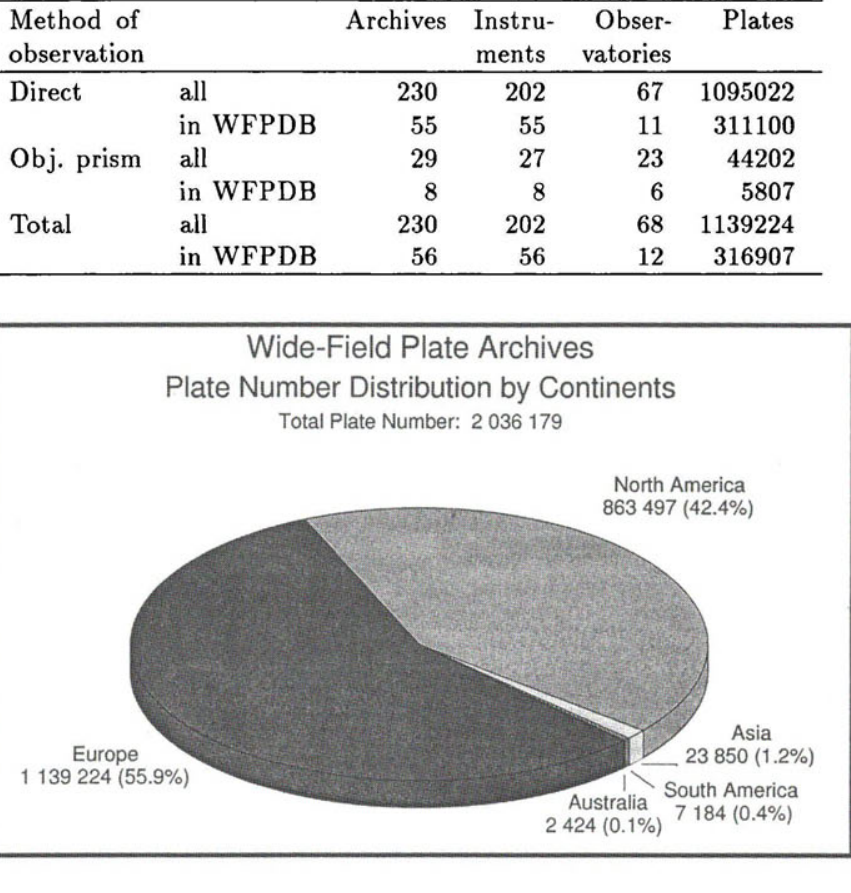
Fig. 1. Distribution of the number of wide-field plates by continents. regions is shown. More than half of the plates are in the Western and Central Europe and nearly 40% (450 000) are in Russia and the FSU republics. Distribution of the number of plates by countries, separately for the direct plates and the objective prism plates, is shown in Fig.